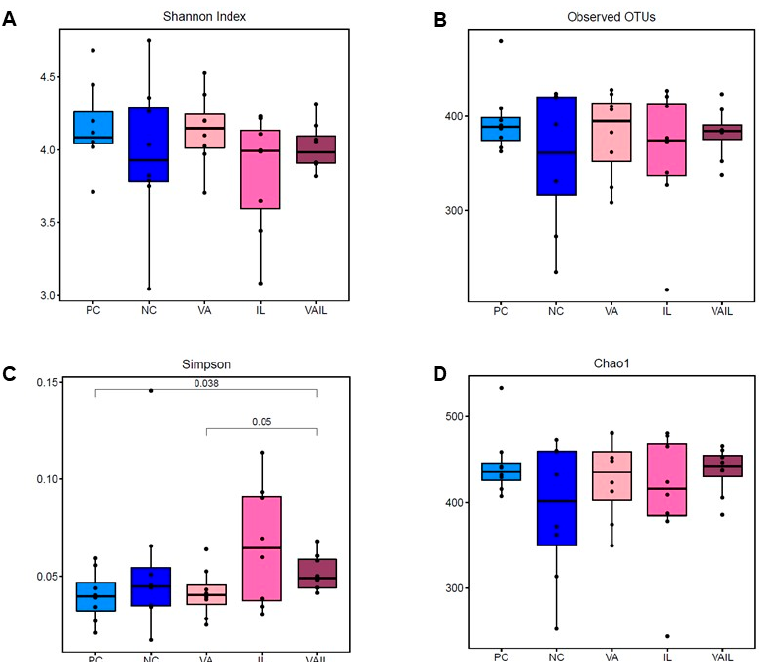
Figure 3. Alpha diversity indices for colon bacterial community in pigs fed with very low protein diets supplemented with isoleucine (Ile) at NRC and valine (Val) above NRC levels, or a combina- tion of the two. ( A ) Shannon, ( B ) Observed operational taxonomic units (OTUs), ( C ) Simpson, and ( D ) Chao1. PC: positive control, standard protein diet; NC: negative control, very low protein diet containing first four limiting amino acids (i.e., lysine, methionine, threonine, and tryptophan) at NRC (2012) levels; VA: NC containing Val above NRC level; IL: NC containing Ile at NRC level; VAIL: NC containing Val above NRC and Ile at NRC levels. Each node represents an individual pig. The means are different with p ≤ 0.05. n = 8.